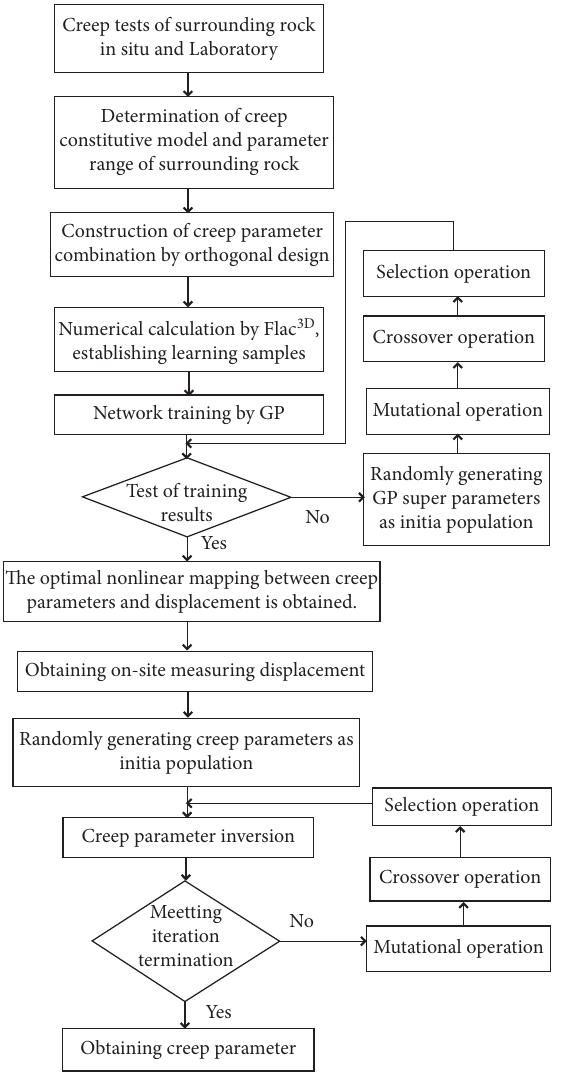
Figure 2: Flow chart of creep parameter